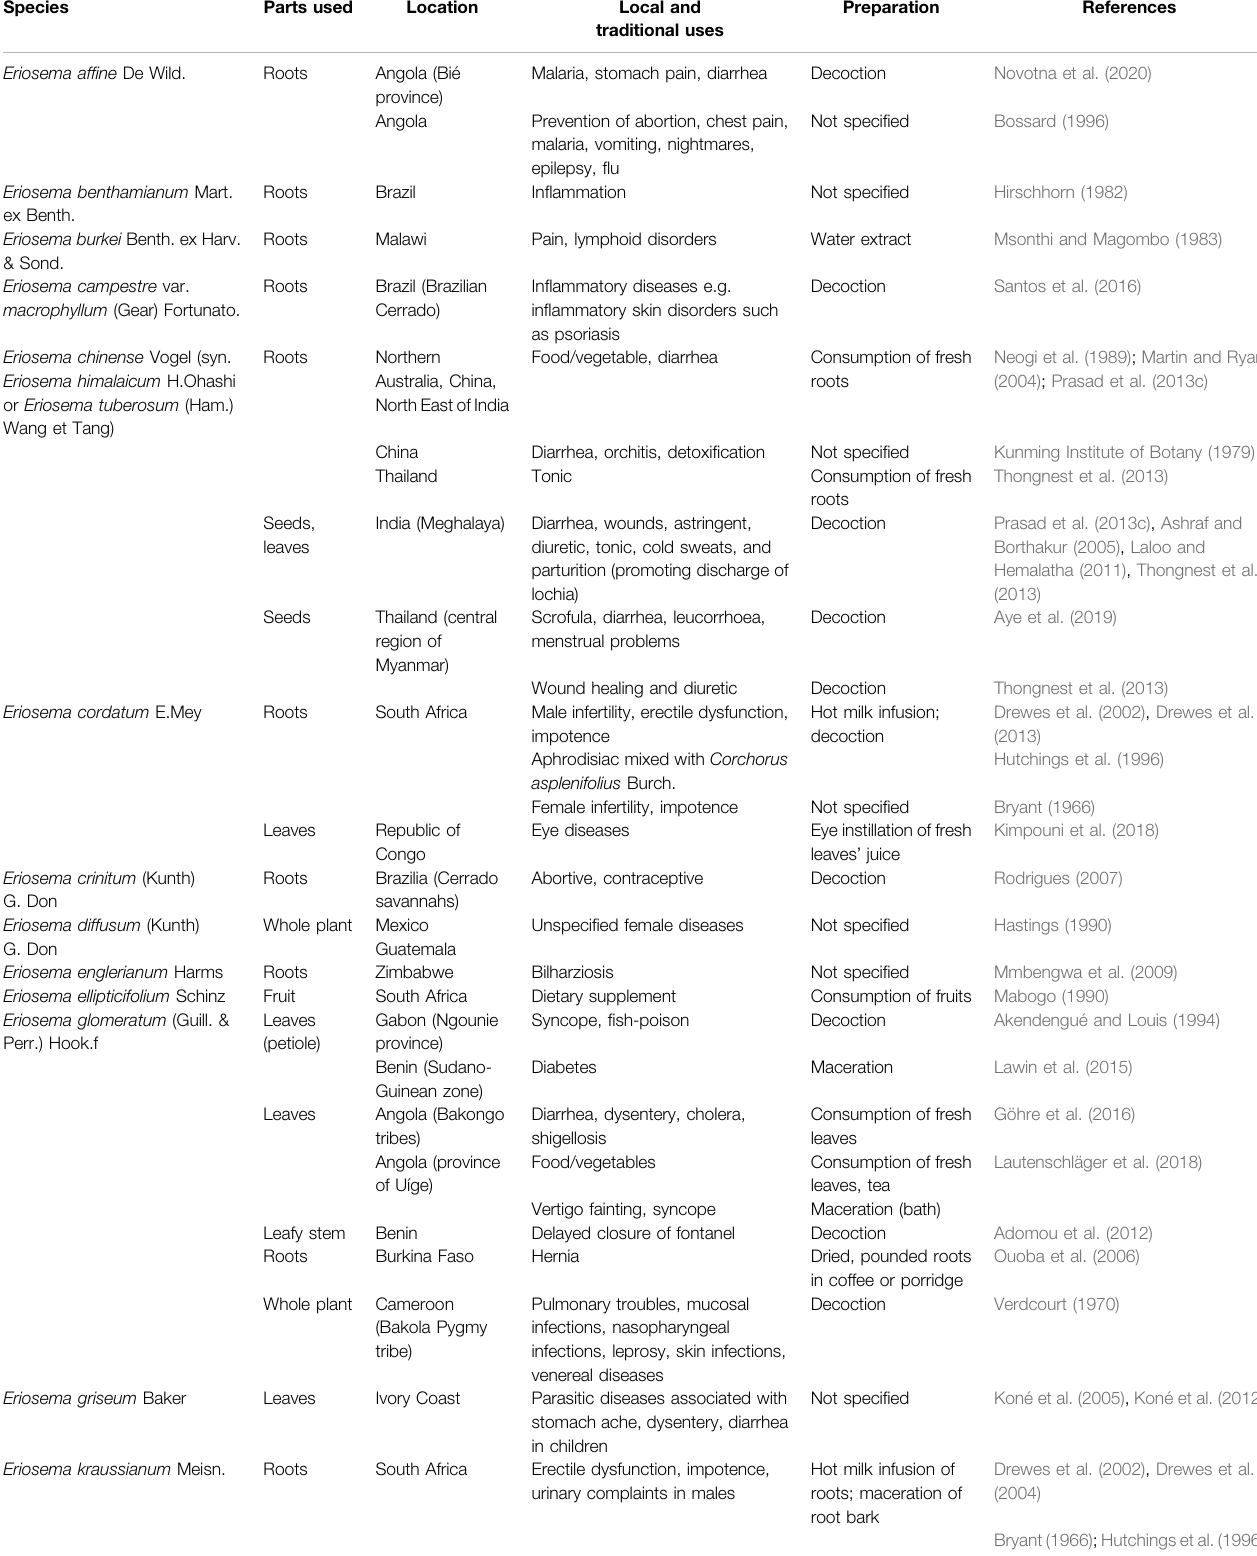
TABLE 1 | Ethnomedicinal indications and local uses of Eriosema species based on the literature data review.